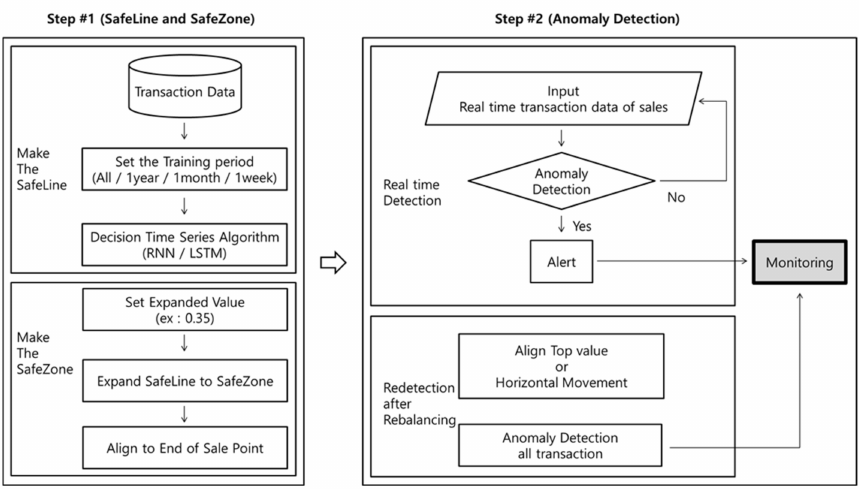
Figure 9. Idea of anomaly detection system for horse racing using machine